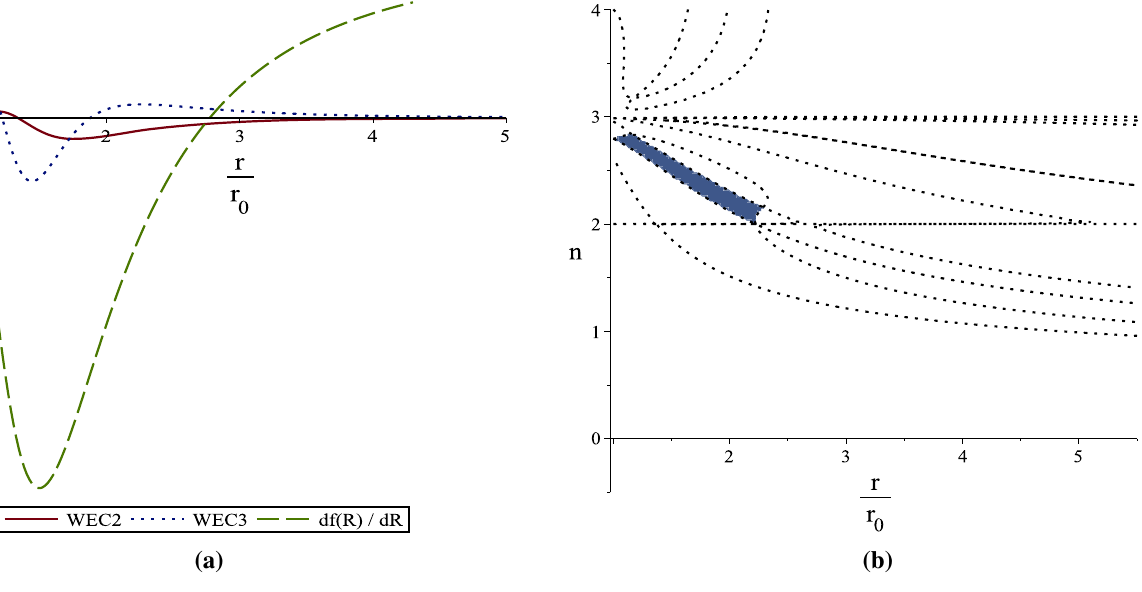
cally flat wormholes of the Hu–Sawicki model, which respect NEC. In these figures we set m = 1 ,μ = 5 , R ∗ = 0 . 001 and r 0 = 15